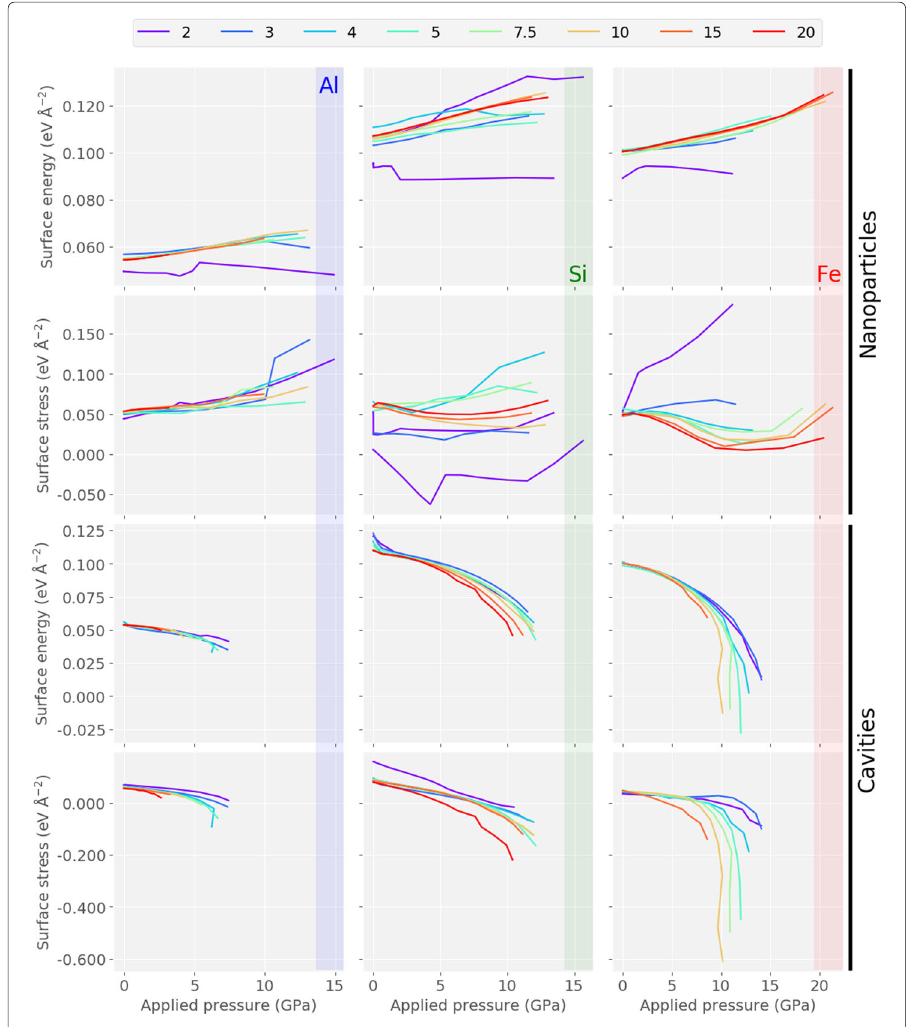
Fig. 4 Surface energy and stress of nanoparticles (upper rows) and cavities (lower rows) as a function of applied pressure, for aluminum (left column), silicon (middle column) and iron (right column). Each curve corresponds to a nanoparticle/cavity diameter value, in a 2 nm to 20 nm range. Two different 2 nm Si nanoparticles have been investigated, which explains the presence of two violet curves in the corresponding